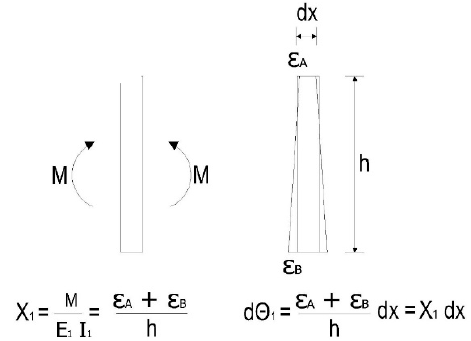
Figure 29. Analysis of the curvature of a section.